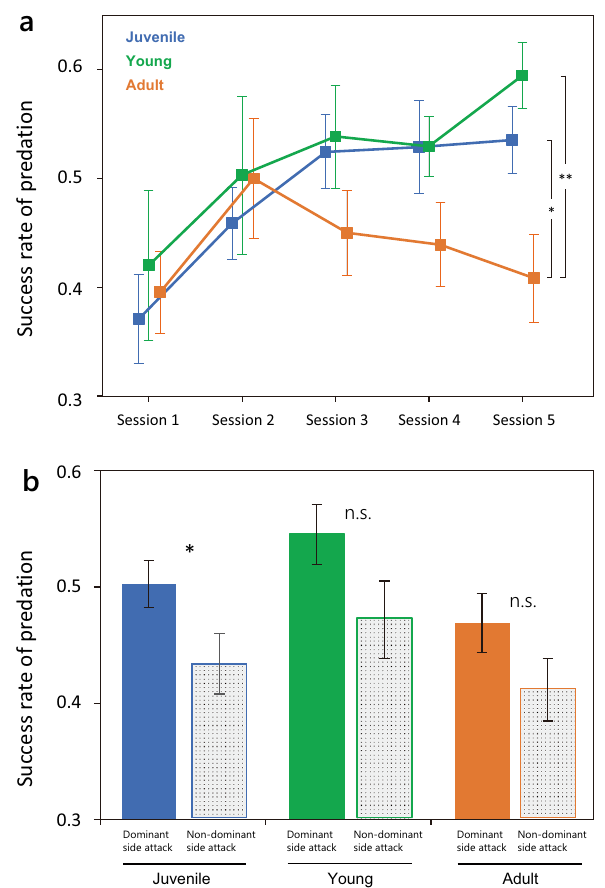
Figure 4. Successful predation during test sessions. ( a ) Changes in the success rate of predation from Session 1 to Session 5. Error bars indicate 95% confidence intervals. p -values for Session 5 are derived from generalized linear mixed model (GLMM) analysis. * p < 0.05; ** p < 0.01. ( b ) Overall success rates of predation attempts from dominant and non-dominant sides (mean ± SE). p -values are from GLMM analysis. * p <